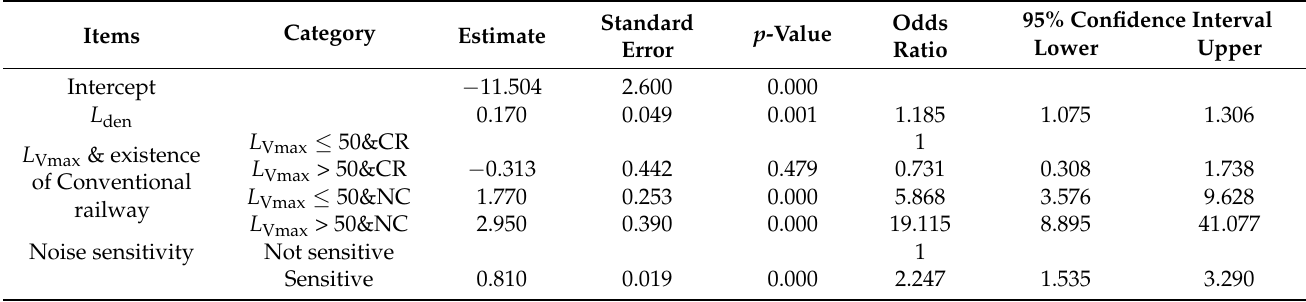
Table 5. Multiple logistic regression analysis of high noise annoyance by L den , L Vmax and existence of conventional railway (AUC = 0.747).